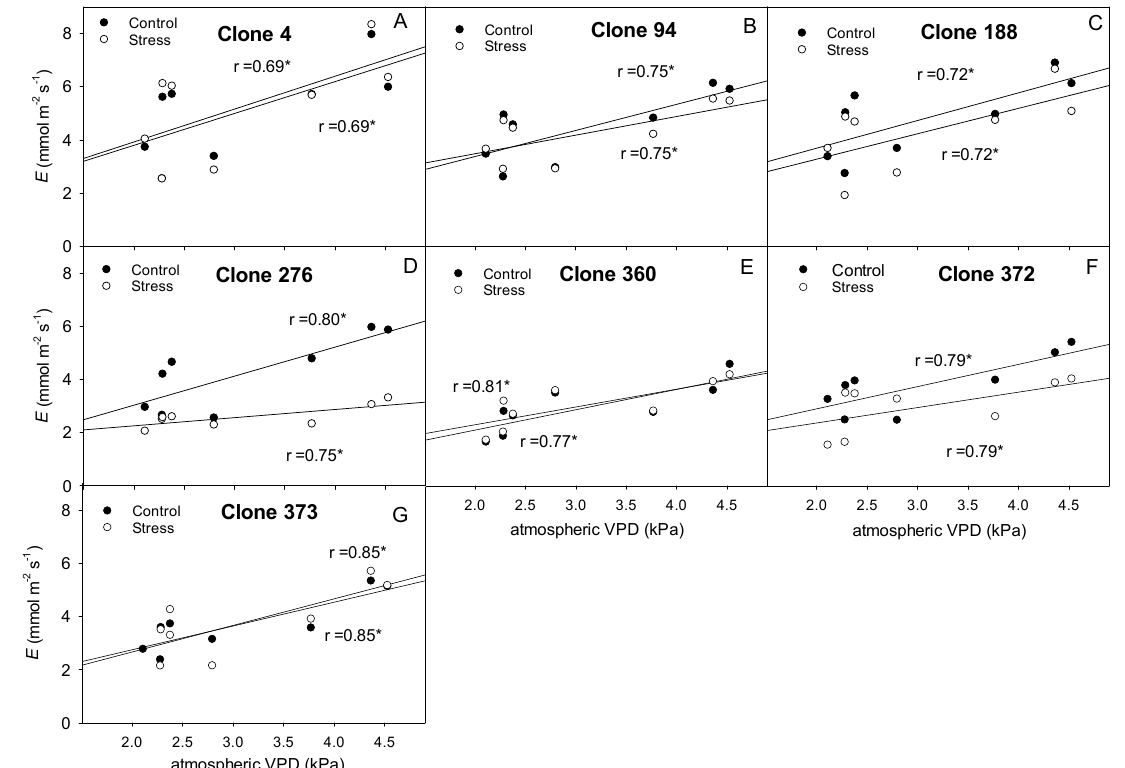
Figure 7. Relationships between atmospheric vapour pressure deficit (VPD) and leaf transpiration rate ( E ) for each irrigation treatment in the different clones. Data from daily measurements of VPD and E measured at the same time (from early morning to afternoon) during the growing season (from July to September) in 2020. * P <0.05.